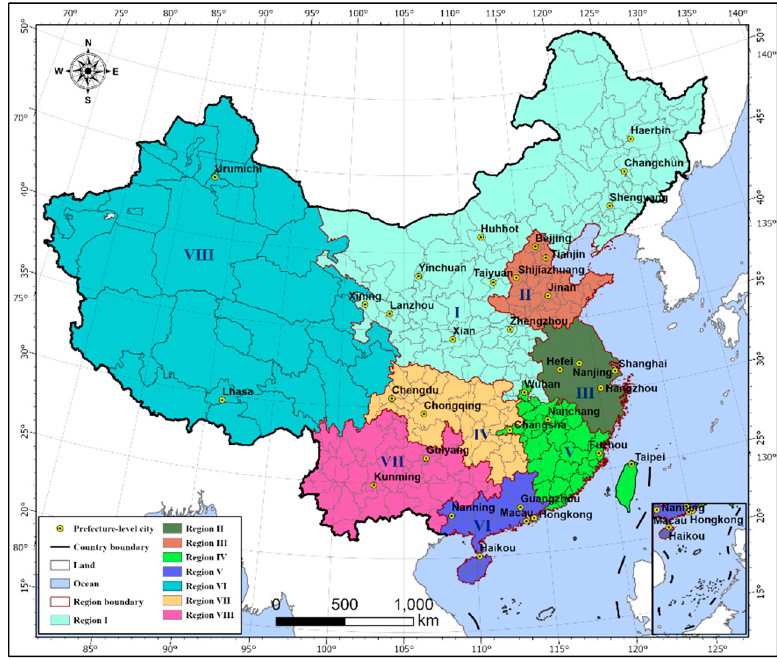
Figure 5. Regionalization result of food culture based on cuisine preference. To illustrate the structural characteristics of the proportion these cuisines in each district further, the ratio boxes and their mean lines of each kind of cuisine at prefecture level and city level were drawn, as shown in Figure 6 and Table 2. The proportion of restaurants corresponding to Sichuan, Fujian, Shandong, and Zhejiang cuisines was relatively stable in more than 300 prefecture-level cities, whereas the proportion of other cuisines in different prefecture-level cities was relatively unstable. The eight regions can be divided into two categories, Region II to VII with high standardized values, while Region I and VIII with low standardized values. Region II had a strong preference for Zhejiang, Jiangsu and Anhui cuisines. In addition, Region II had a high preference, which was close to the third quartile threshold, for Guangdong cuisine. Other cuisines were on average or low level. In Region III, Shandong and Anhui cuisines were the main preferences, whereas the preferences for other cuisines were at a moderate level. Region IV had the strongest inclusiveness to all major cuisines, with a high preference for Fujian, Guangdong, Hunan, and Zhejiang cuisines. The preferred degree of zoning V to Guangdong cuisine, Hunan cuisine was relatively high, Shandong cuisine, Zhejiang cuisine was relatively low, and the preferred degree to other cuisine was in the middle level. Region VI had a high preference for Sichuan, Jiangsu, and Guangdong cuisines, a low preference for Anhui cuisine, and a medium preference for other cuisines. Region VII, which basically belonged to Hunan cuisine’s catering culture area, had a strong preference for Hunan cuisine. Combining with the mean line, the proportion of characteristic restaurants of these cuisines in Region VIII remained at a low level. On this basis, people in this area had a neutral preference for eight cuisines and had no particular preference of any cuisine. Region I had a low preference for Anhui cuisine and a medium preference for other cuisines. Generally, Anhui, Guangdong, Hunan, and Zhejiang cuisines were popular in many districts. Particularly, Hunan and Sichuan cuisines, which were above moderately preferred in almost every district, were the most popular. Table 2. Characteristic variables of the box-plot of eight famous Chinese cuisines.